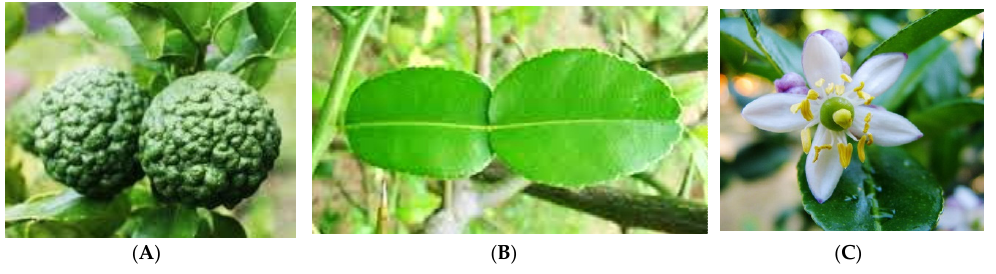
Figure 4. The ( A ) fruit; ( B ) leaf; and ( C ) flower of C. hystrix. (Photos kredit: Robyn Jay, Forest Starr and Kim Starr, David Rofas)